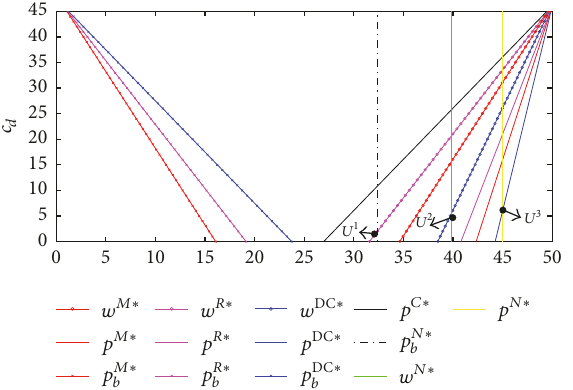
Figure2:Effectsof 𝑐 𝑑 onpricingstrategiesofsupplychainmembers.